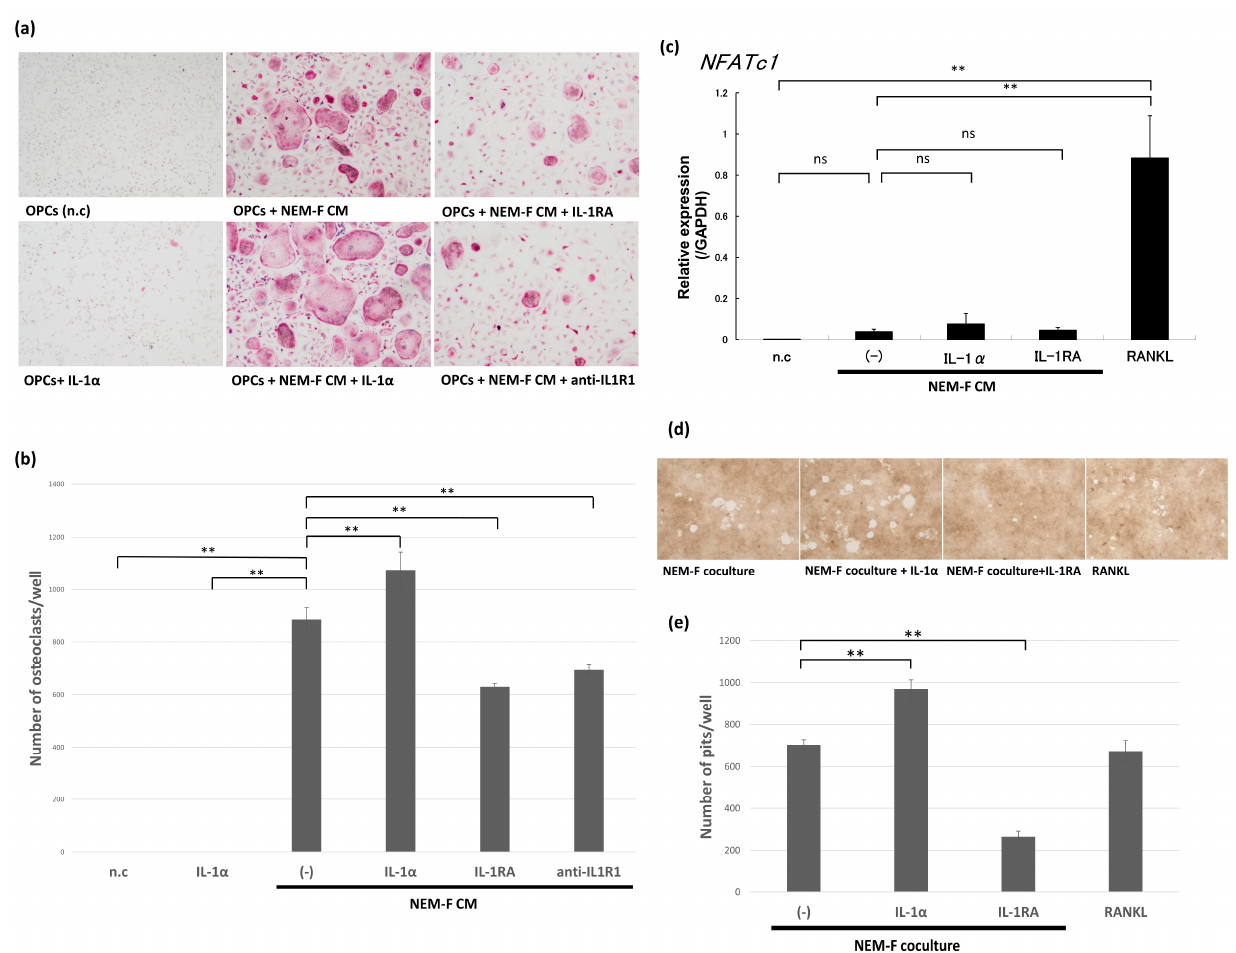
Figure 3. The effects of IL-1 and IL-1RA on osteoclastogenesis induced by the culture supernatant of NEM-F cells and on the expression of NFATc1 in these cultures. ( a ) Evaluation of the effects of IL-1, IL-1RA, and an antagonistic antibody for IL-1R1 on osteoclastogenesis induced by the culture supernatant of NEM-F cells. Representative views of TRAP staining after 5 days of culture. ( b ) The number of osteoclasts induced by the culture supernatant of NEM-F cells with or without treatment with IL-1, IL-1RA, or an antagonistic antibody for IL-1R1. ** p < 0.01 (one-way ANOVA with the Dunnett’s method). ( c ) Quantitative PCR analysis of the expression of NFATc1 in OPCs cultured with culture supernatant of NEM-F cells with or without supplementation of IL-1RA or IL-1 α relative to the expression in OPCs cultured with the growth medium with or without supplementation of RANKL. ** p < 0.01, ns: not significant (one-way ANOVA with the Tukey–Kramer method). ( d ) coculture of NEM-F cells and OPCs using a pit formation assay. Representative views of formatted pits after 6 days of culture. ( e ) The number of pits formed by osteoclasts induced by the coculture of NEM-F cells and OPCs with or without supplementation of IL-1RA or IL-1 α . ** p < 0.01 (one-way ANOVA with the Dunnett’s method).